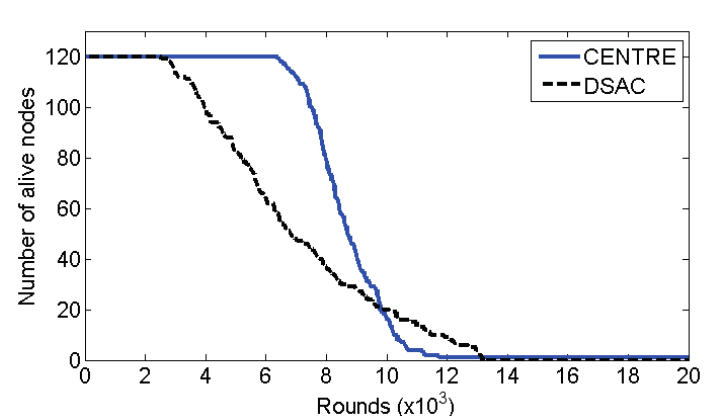
Figure 9. Network